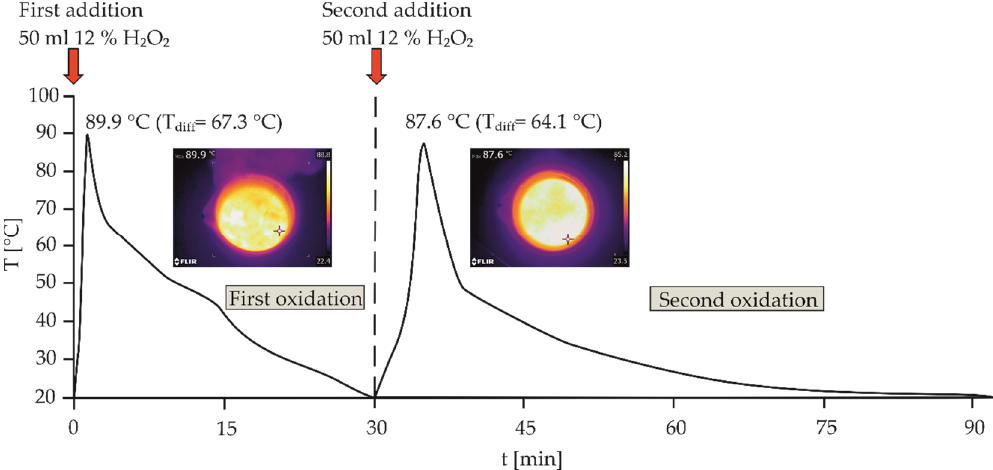
Figure 5. Two-stage oxidation of pyrite during IR thermography testing. The second exothermic event reaches the same maximum temperature of the first oxidation event again, but the cooling down phase takes more time to complete. Complete consumption and decay of hydrogen peroxide during the first oxidation event allowed additional pyrite oxidation.